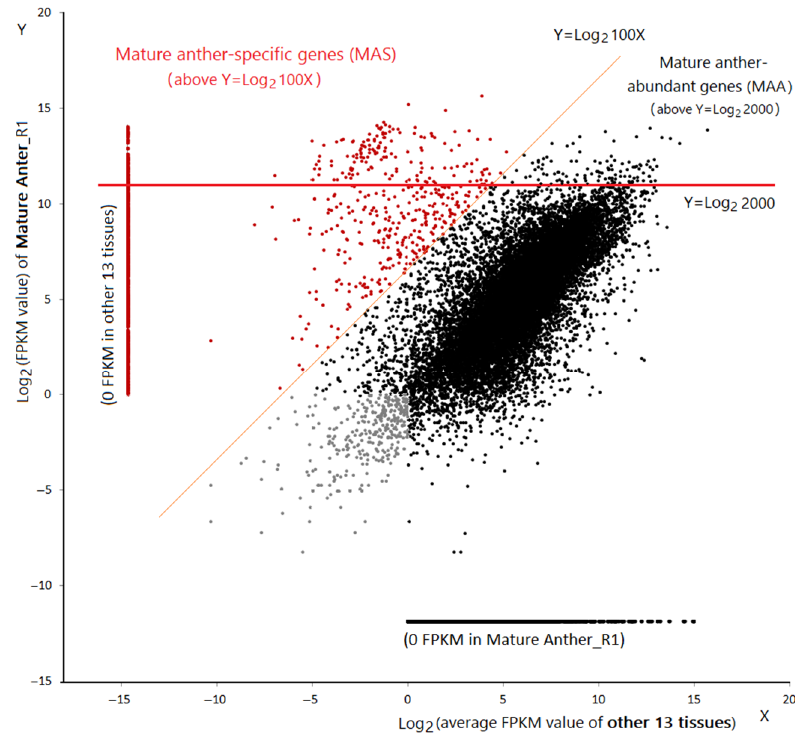
Figure 5. Two-dimension scatter plot of transcript abundance in mature anther vs. other 13 tissues. The x -axis indicates the average of transcript abundances in the other 13 tissues and the y -axis indicates the transcript abundance detected in mature anthers by RNA-seq [70]. Each point represents a unique gene model. Mature anther-specific genes (MAS) are distributed above the orange line ( y = log 2 100x) and mature anther-abundant genes (MAA) are located above the red line ( y = log 2 400). MAS are indicated in red dots and the grey dots represent the trace-expressed genes.